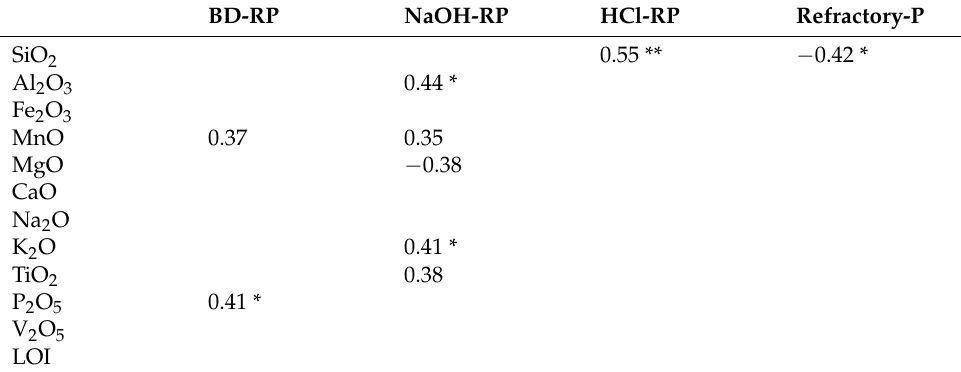
Table 3. Kendall’s tau correlation coefficients between PP fractions and major elements ( n = 24).